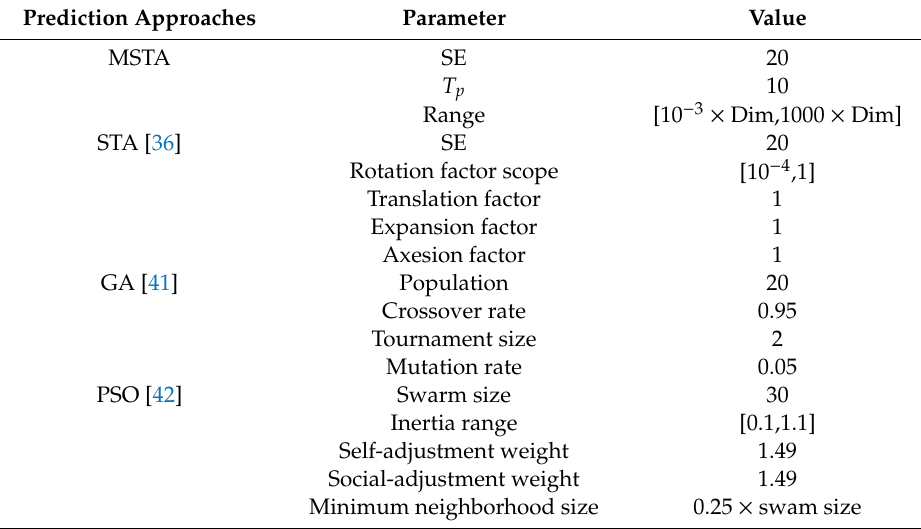
Table 1. Parameter setting for each optimization model involved. GA, genetic algorithm; PSO, particle swarm